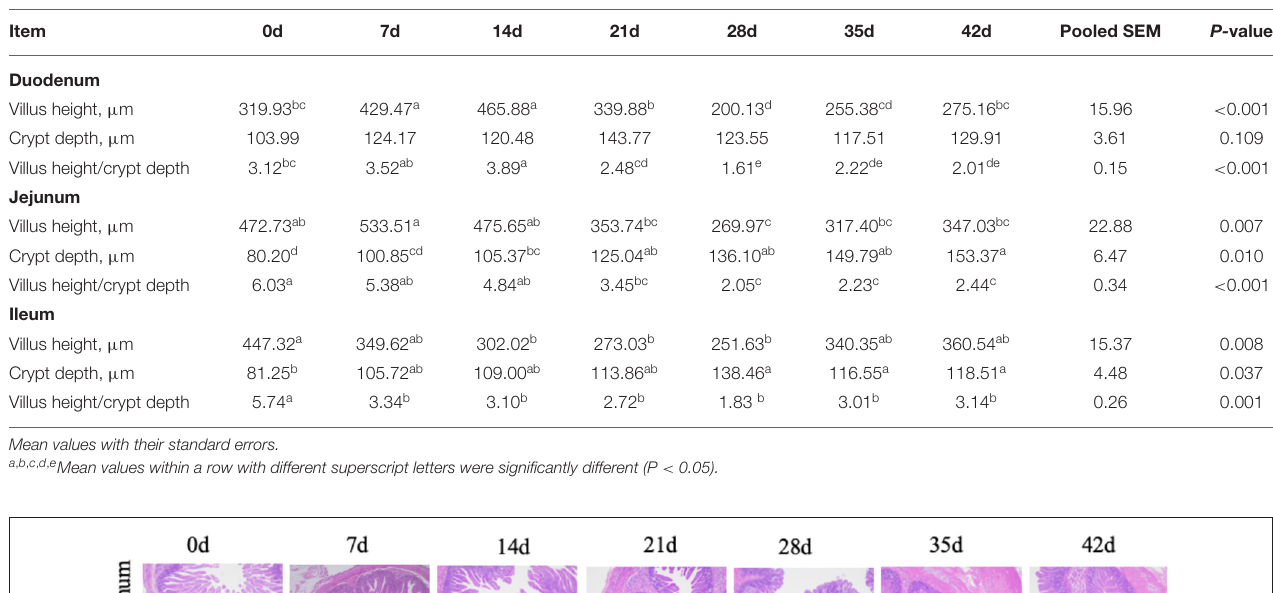
TABLE 2 | Effect of piglet age on intestinal morphology.